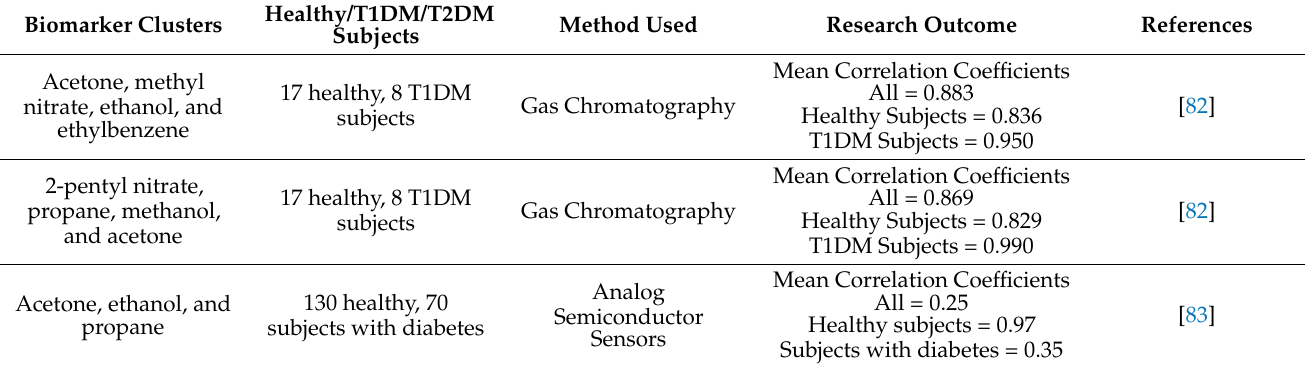
Table 4. VOC Clusters for Diabetes